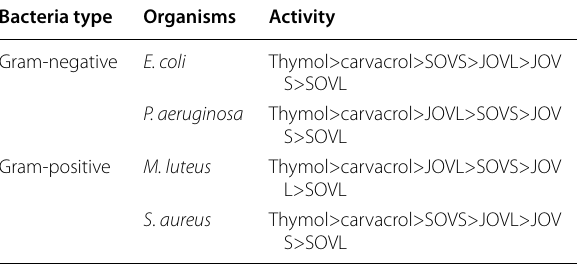
Table 3 Antimicrobial activity of essential oils and their purified compounds Bacteria type